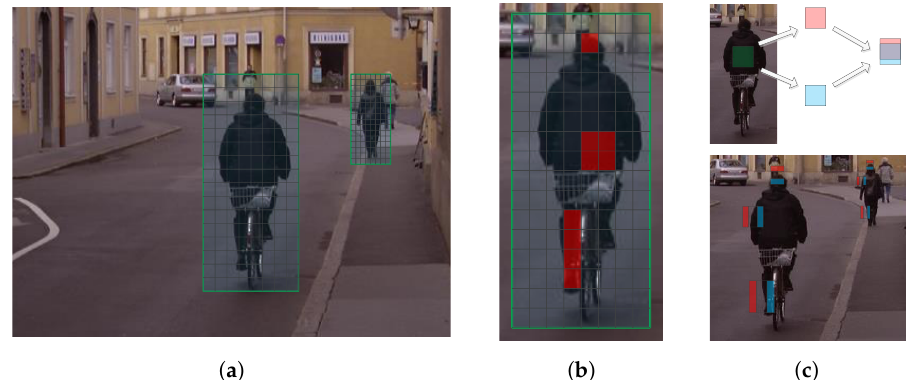
Figure 3. Illustration of the feature extraction process of our method. ( a ) Feature maps of different scales are divided into the same number of cells whose size vary with the pedestrian size; ( b ) Features are extracted by average pooling in different regions which are composed of one or more cells; ( c ) Top: Pooling in feature gradient maps is equivalent to computing difference of two shifted pooling regions, which has similar effect with Non-Neighboring Features (NNF). Down: Some discriminative features in